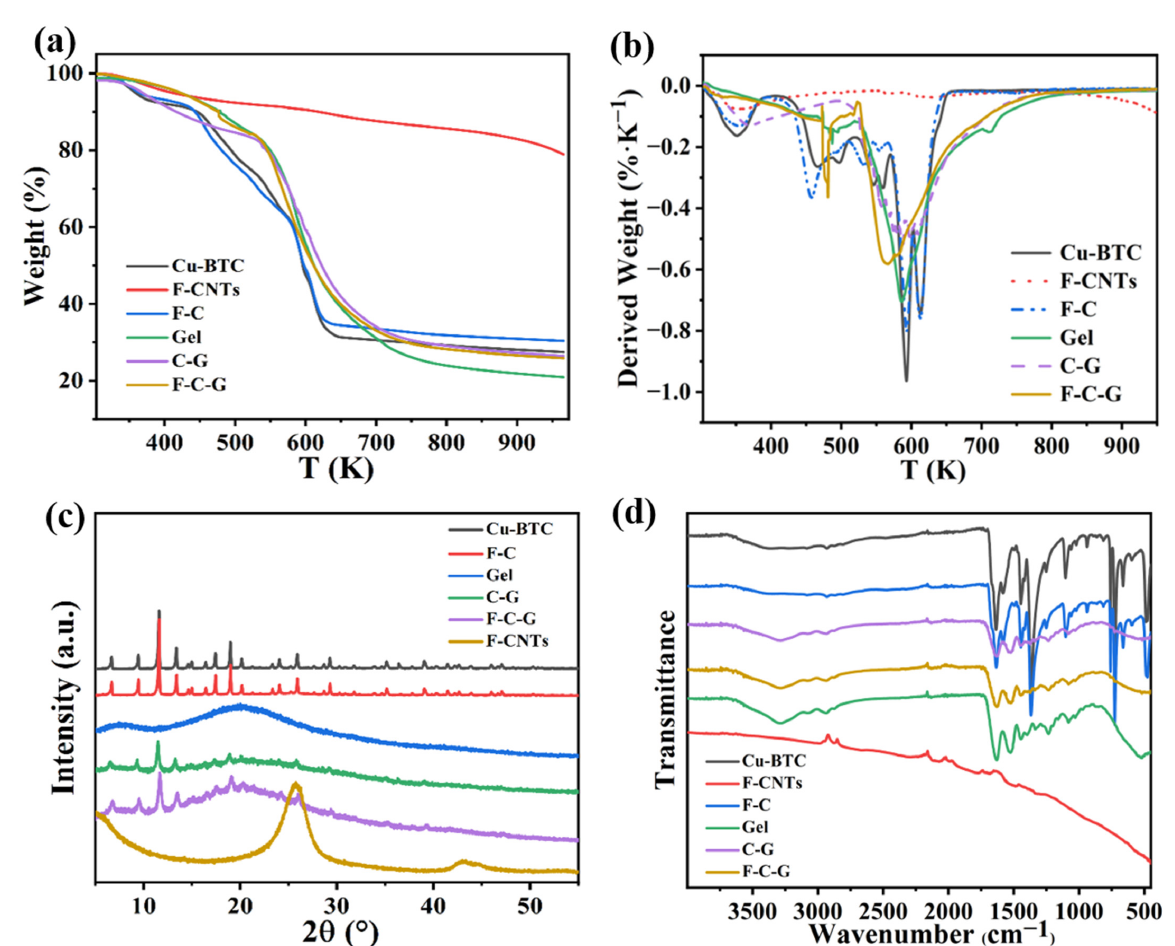
Figure 4. TGA curve ( a ) and DTG curve ( b ) of different materials; XRD ( c ) and FTIR ( d ) results of different materials.